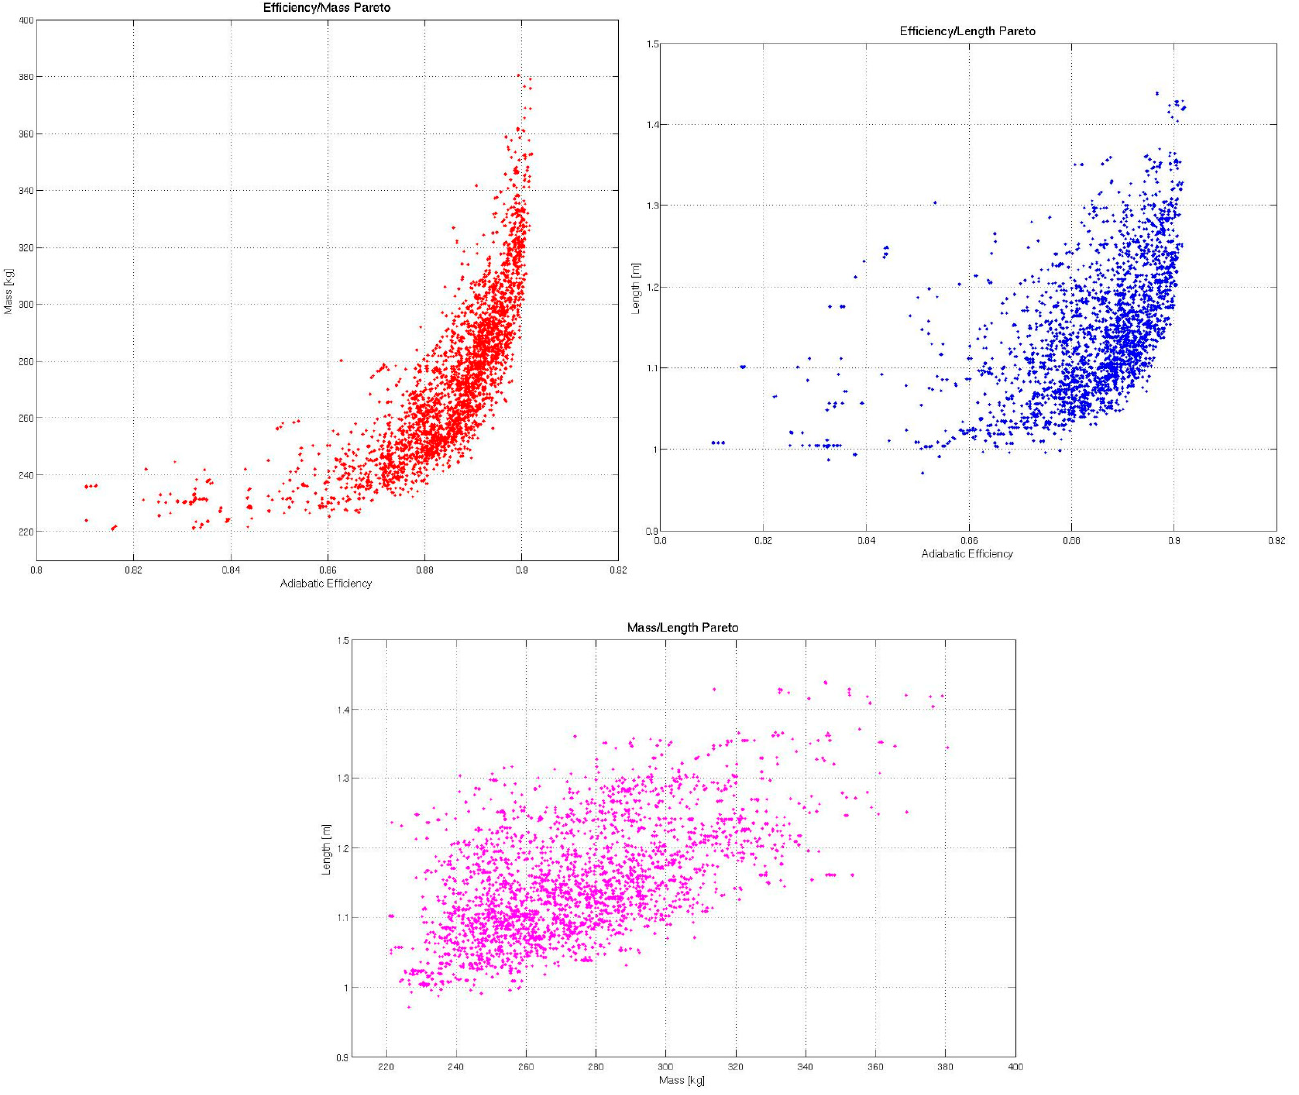
Figure 15. Pareto plot of 100,000 evalutaions for η vs. mass, η vs. length, and length vs. LPC mass.